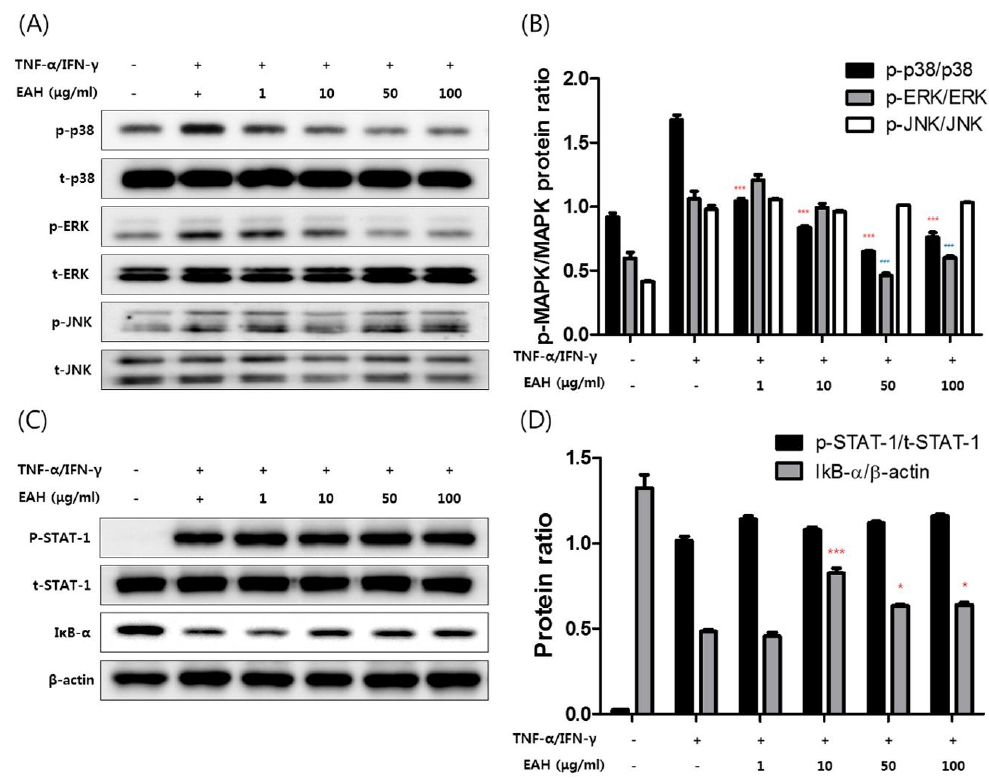
Figure 3. Effects of EAH on phosphorylation of MAPK and STAT-1 and degradation of IκB-α in TNF-α/IFN-γ–stimulated HaCaT cells. The cells were pretreated with the indicated concentrations of EAH for 1 h and then stimulated with TNF-α/IFN-γ (each 10 ng/mL) for 30 min. ( A ) Effects of EAH on phosphorylation of MAPKs such as P38, ERK, and JNK in HaCaT cells. ( B ) Relative abundances of proteins were calculated for the indicated protein ratios. ( C ) Effects of EAH on phosphorylation of STAT-1 and degradation of IκB-α in HaCaT cells. ( D ) The bar graphs represent quantitative densities of the bands. The results shown are representative of ( A , C ). Data are represented as mean ± SD of three independent experiments. * p < 0.05, *** p < 0.001, and ### p < 0.001 compared with the TNF-α/IFN-γ-treated group.